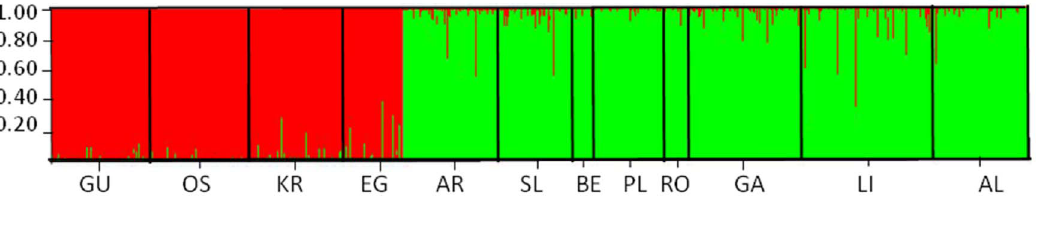
Figure 4. Principal Component Analysis on allele frequencies [ 34 ] . Note the differences in variability explained by the two axes (approx. 88% and 3% respectively).